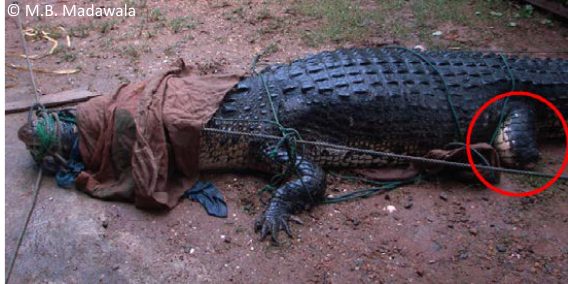
Figure 5. Capture (squares) and translocation (circles) sites for nine Saltwater Crocodiles during